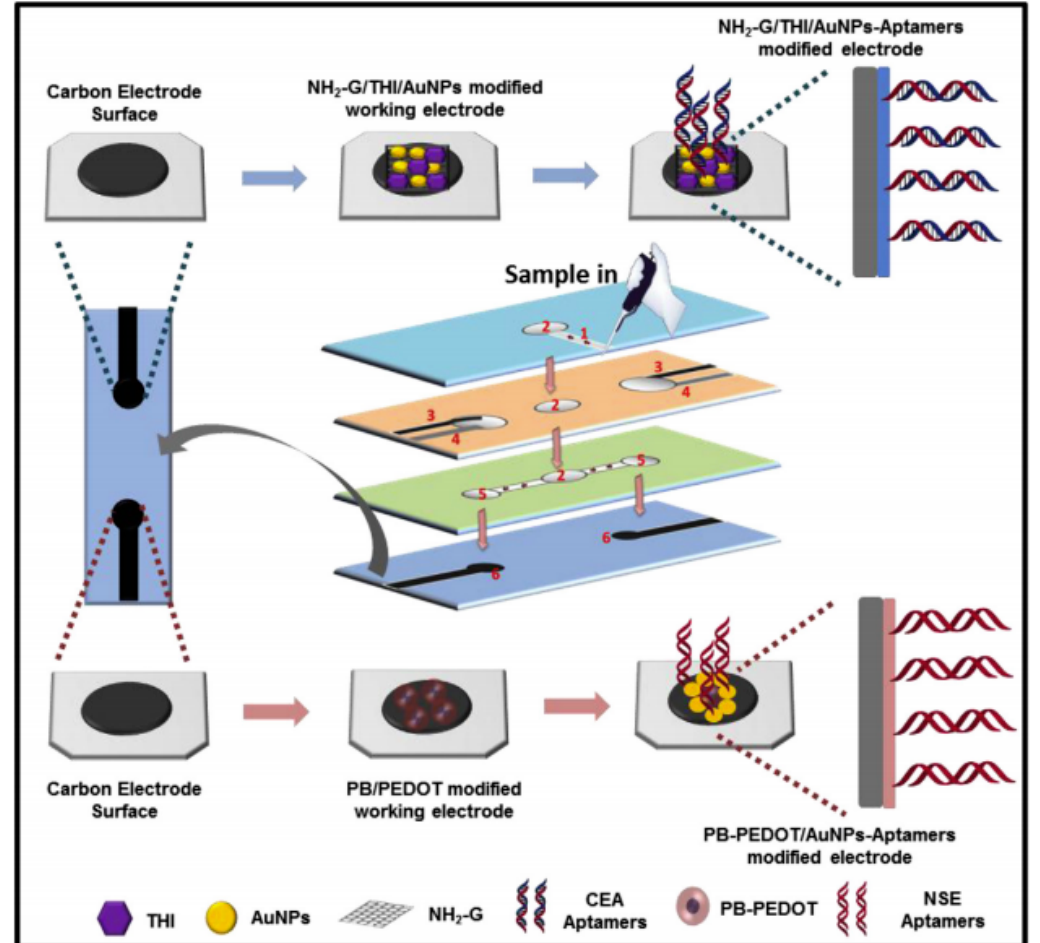
Figure 5. Fabrication and modification process of the multiplex electrochemical paper-based aptasensor [85]